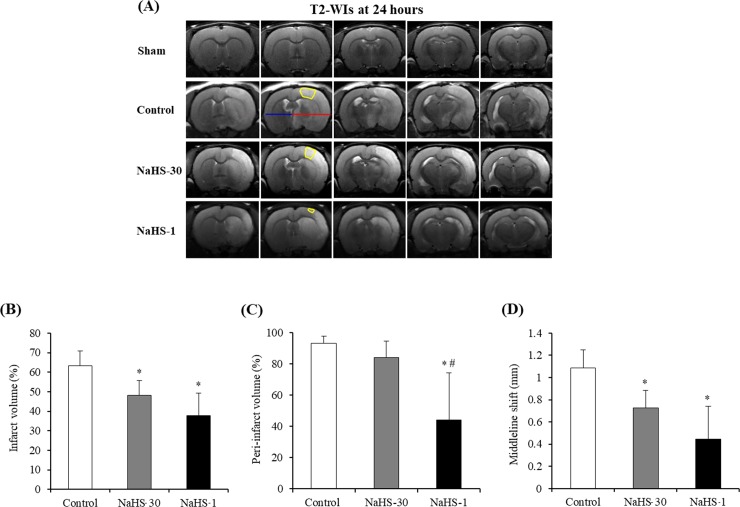
Infarct volumes and midline shift (MLS).(A) The peri-infarct volume was measured from the peri-infarct region (yellow region) on T2-WIs at 24 h after ischemia in representative rats from each group. To calculate the MLS, the distance between the outer border of the cortex and the middle of the third ventricle was measured from the ipsilateral (red line) and contralateral (blue line) sides. (B -D) The total infarct volume (B), peri-infarct volume (C) and MLS (D) were lowest in the NaHS-1 group, followed by the NaHS-30 and control groups. The peri-infarct volume was significantly lower in the NaHS-1 group than in the NaHS-30 group. Data are presented as mean ± standard deviation (n = 8 rats in each group). *P < 0.001 vs. the control group, # P < 0.001 vs. the NaHS-30 group.